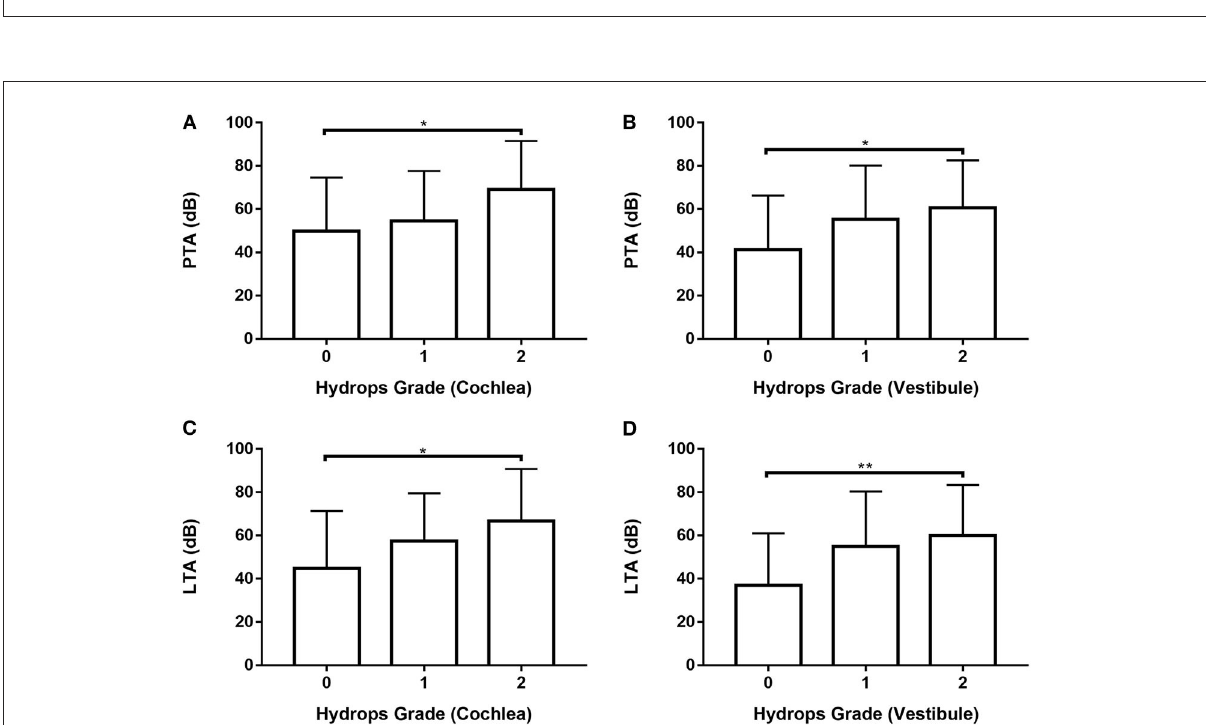
FIGURE4 Analysis of PTA ( A , B ) and LTA ( C , D) according to hydrops grade in the cochlea ( A , C) and vestibule ( B, D ) in 80 ears with definite MD by one-way ANOVA with Scheffé’s post-hoc multiple comparison test. * p < 0.05; ** p <